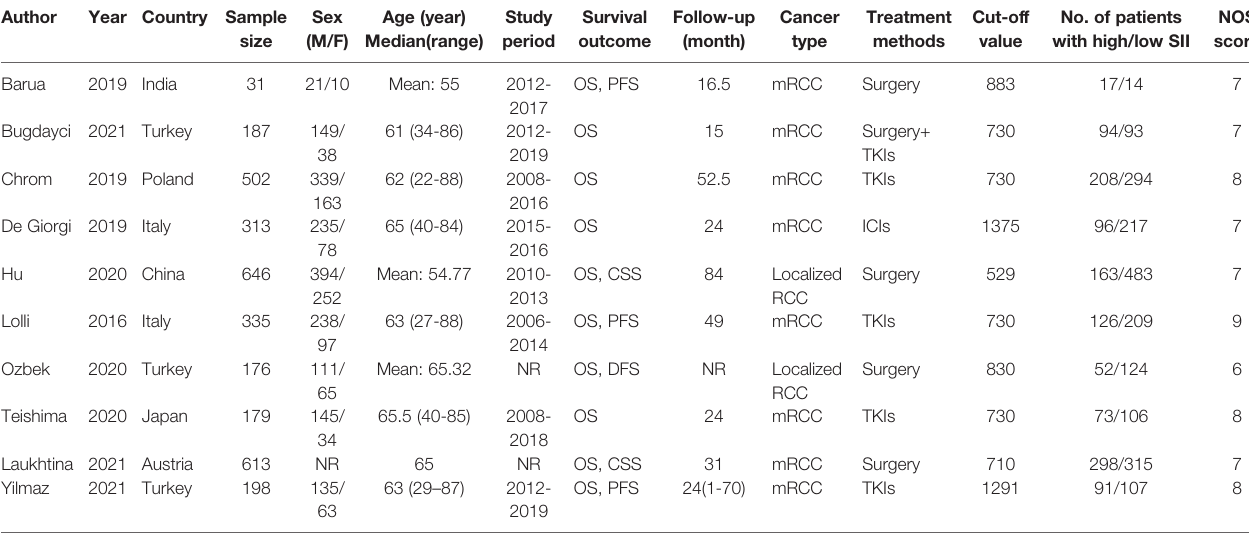
TABLE 1 | Main characteristics of all included